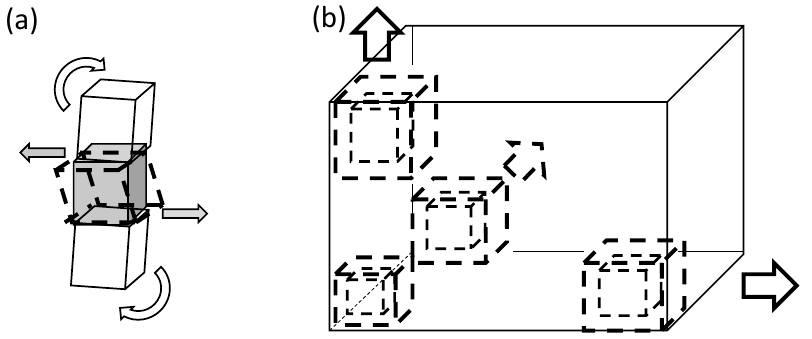
Figure A2. Conceptual illustration of ( a ) shear force and ( b ) longitudinal elastic